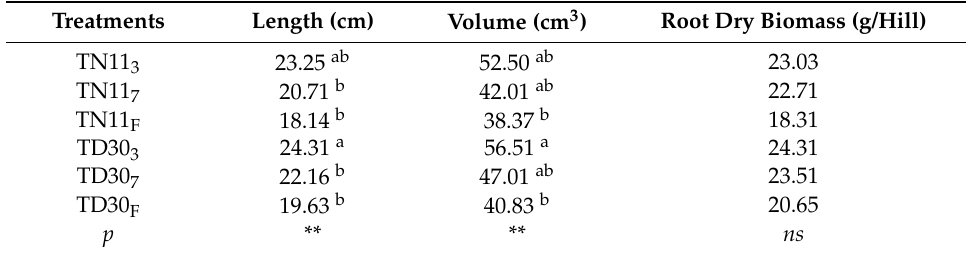
Table 3. Effect on irrigation regimes on root parameters.